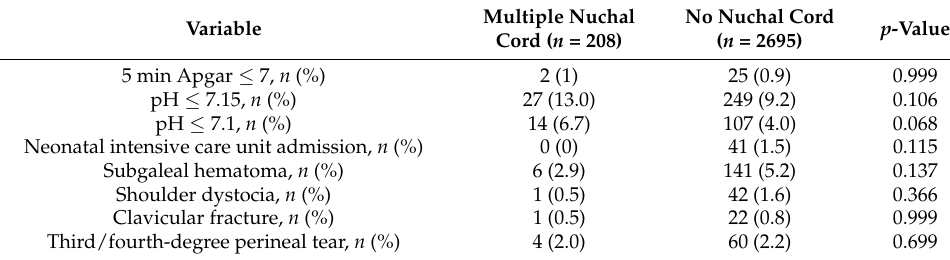
Table 4. Maternal and neonatal outcomes stratified by multiple ( ≥ 2) nuchal cord. Variable